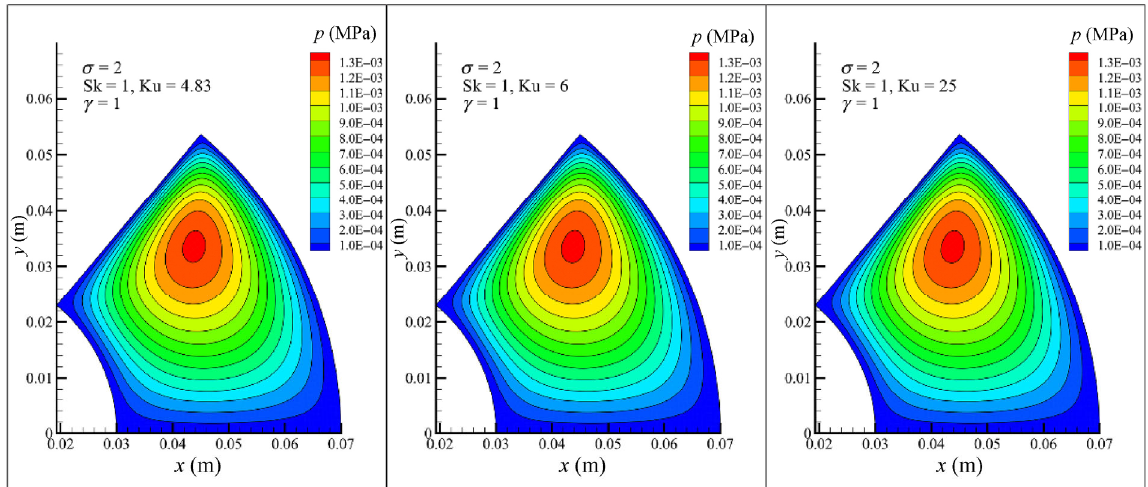
Fig. 8 Average fluid pressure distributions with various Ku. Sk = 1,